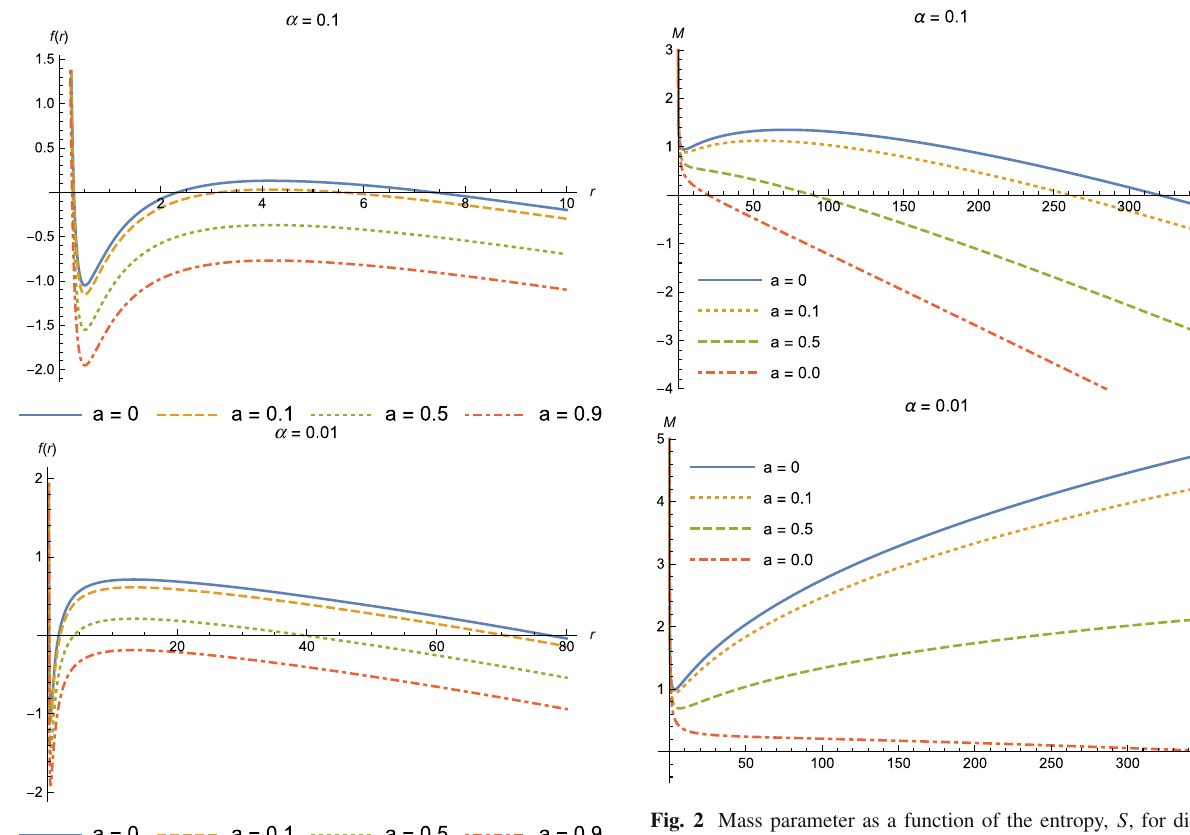
Fig. 2 Mass parameter as a function of the entropy, S , for different values of a and